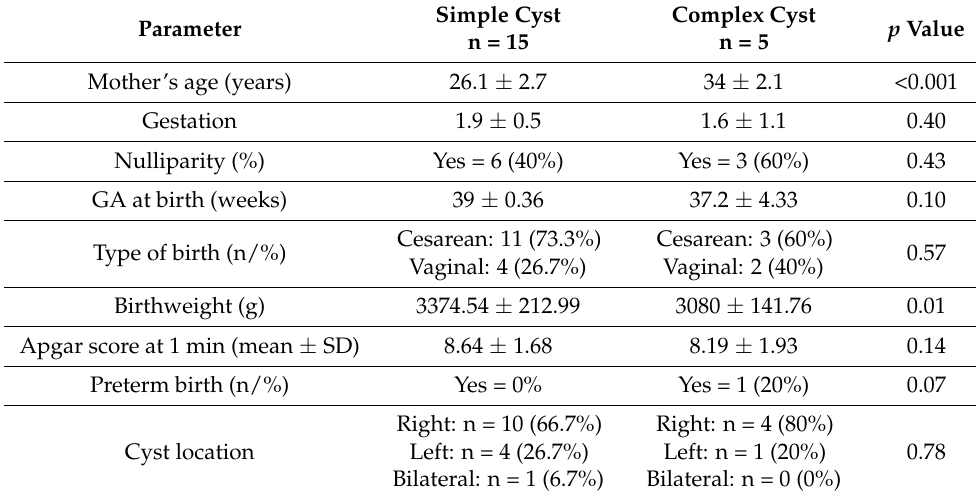
Table legend: GA: gestational age; US: